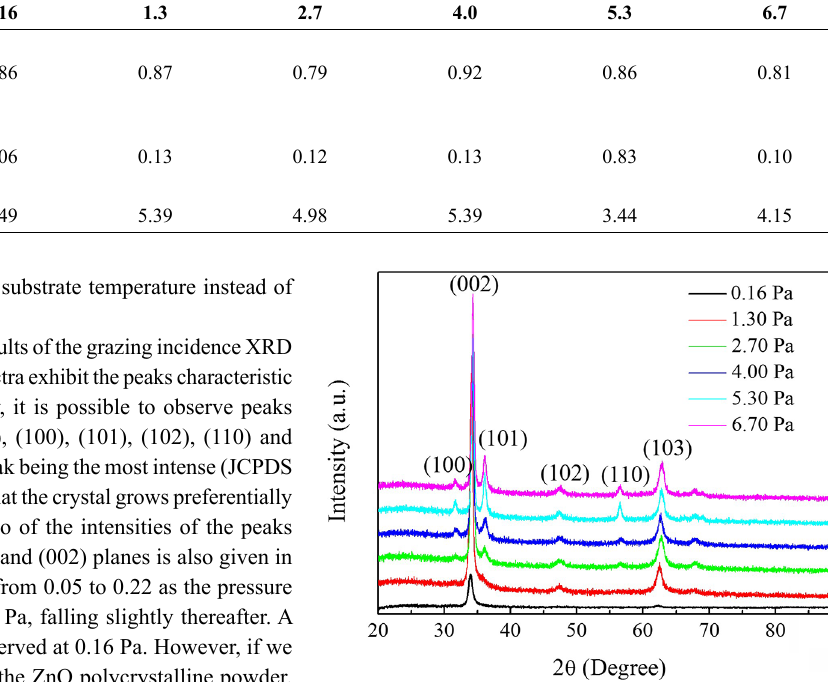
Figure 3. Grazing incidence X-ray diffraction spectra of the AZO films at different sputtering